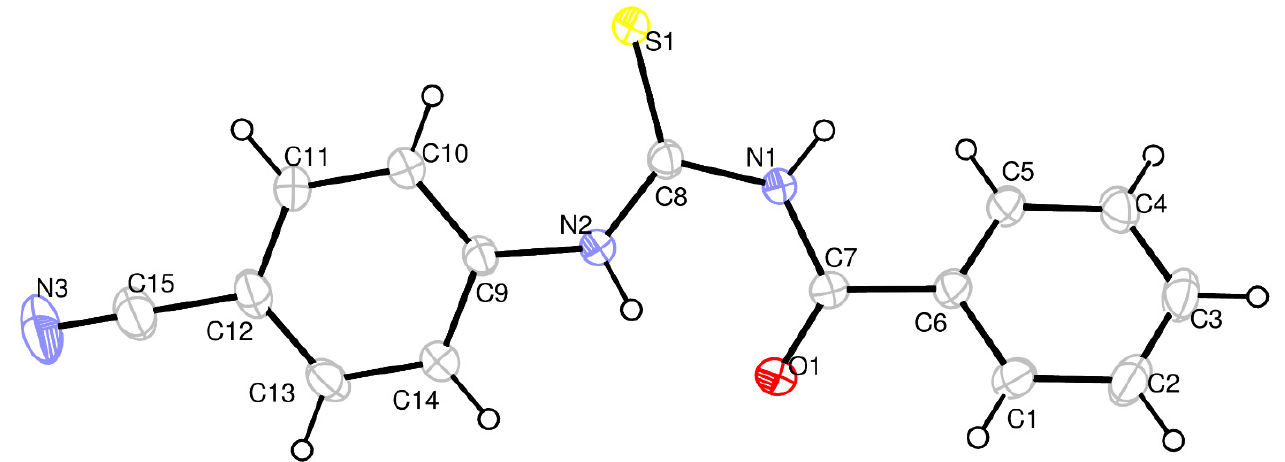
Figure 2. The ORTEP drawing of the N-Benzoyl-N’-(4 ′ -cyanophenyl)-thiourea ( 1 ) with thermal ellipsoid at 30% level.